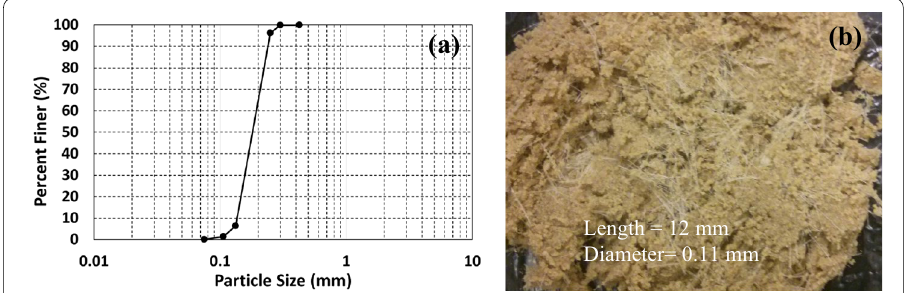
Fig. 2 a Grain size distribution curve for Toyoura sand b PVA